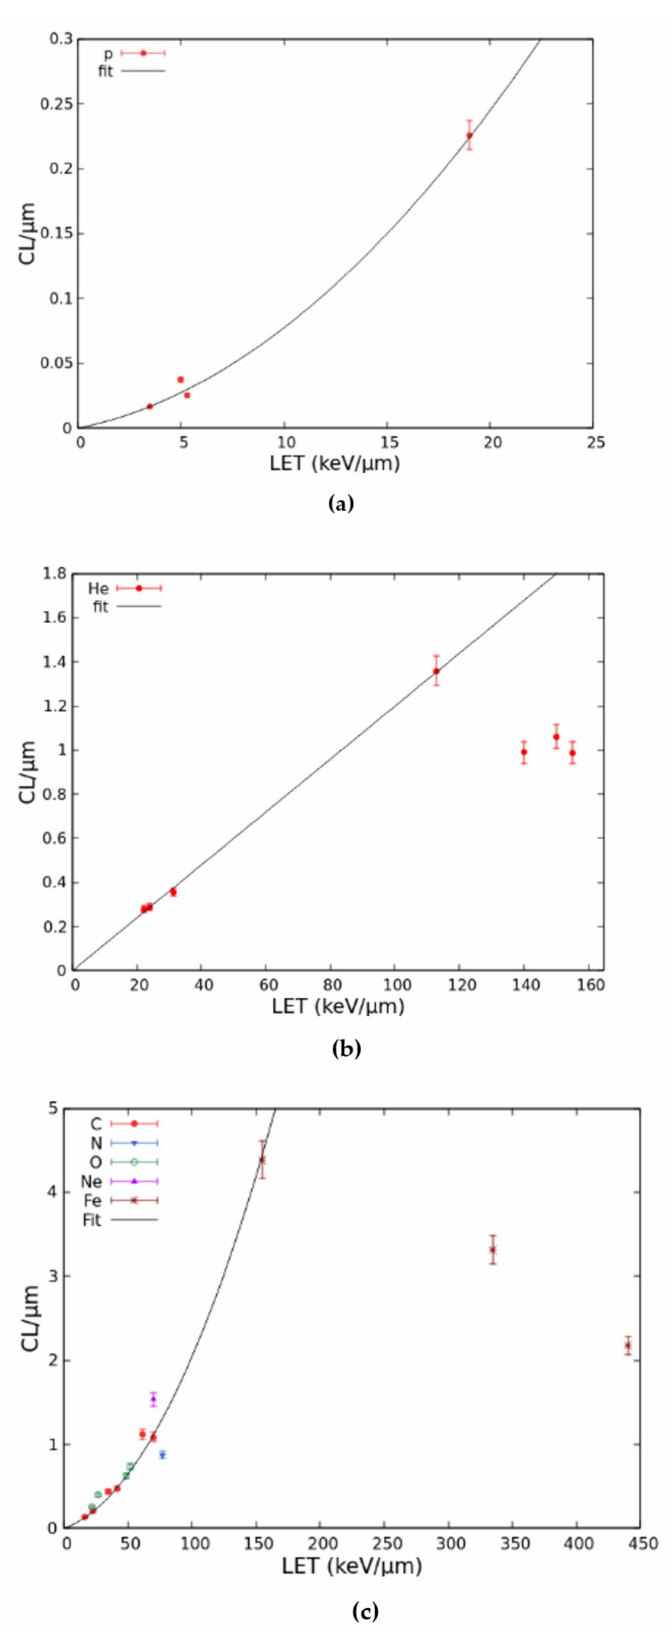
Figure 5. LET-dependence of the CL yield for protons ( a ), He-ions ( b ), and heavy ions ( c ). Each point represents a CL yield, and the lines are fits as described in the